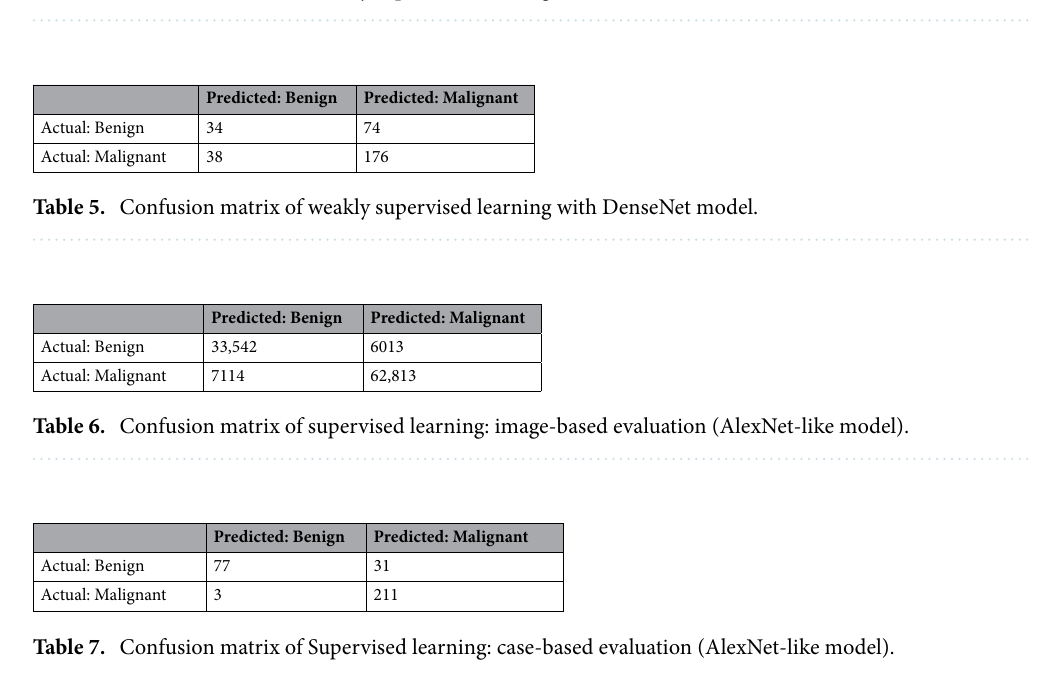
Table 4. Confusion matrix of weakly supervised learning with ResNet model.